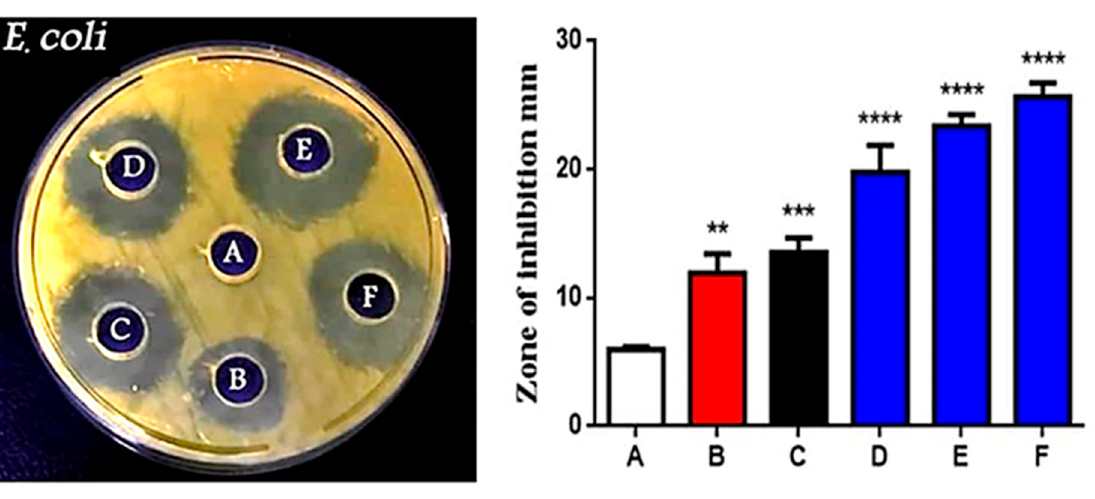
Figure 5. Antibacterial activity of ZnO NPs, Au NPs, and Au/ZnO NCs against E. coli . A, non-treated control bacteria; B, treated with ZnO NPs; C, treated with Au NPs; D, treated with Au/ZnO NCs ratio (1:3); E, treated with Au/ZnO ratio (1:1); F, treated with Au/ZnO ratio (3:1). Values are shown as the mean ± SD of measurements taken in triplicate. ** p ≤ 0.01, *** p ≤ 0.001, **** p ≤ 0.0001.